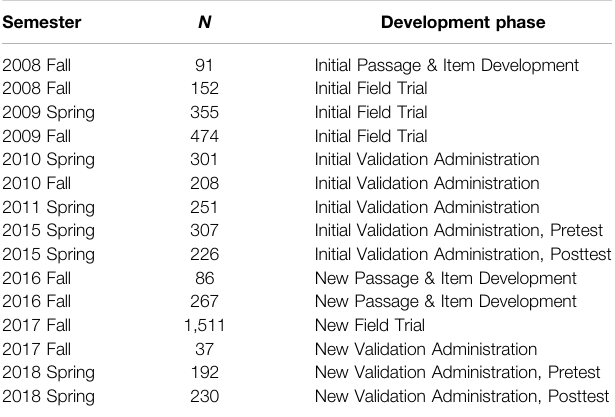
TABLE 3 | Semester for participation, sample size (N), and development